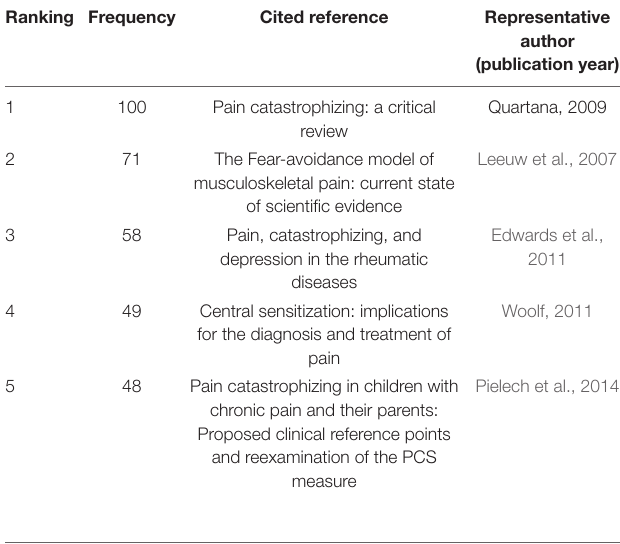
TABLE 7 | The top five cited references for the highest centrality of pain